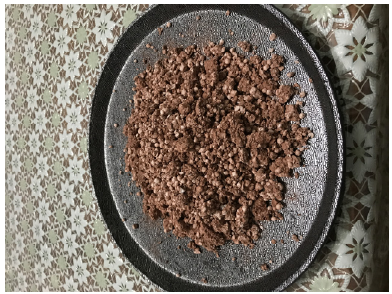
Figure 3. Novel SPS lightweight aggregate.